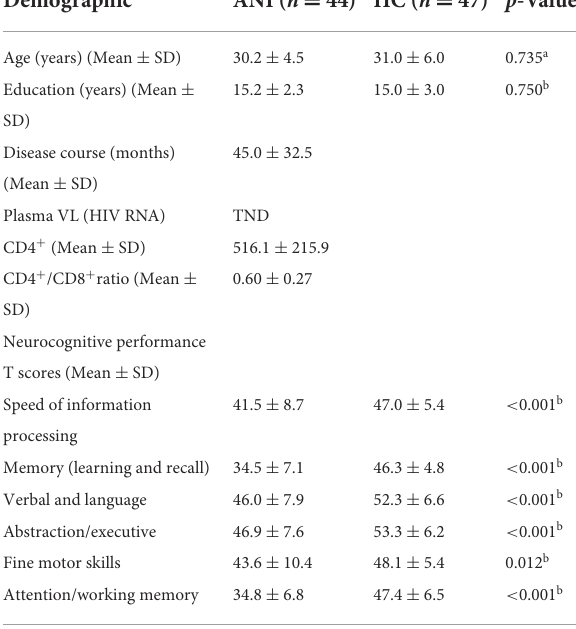
TABLE 1 Demographic and clinical characteristics of the